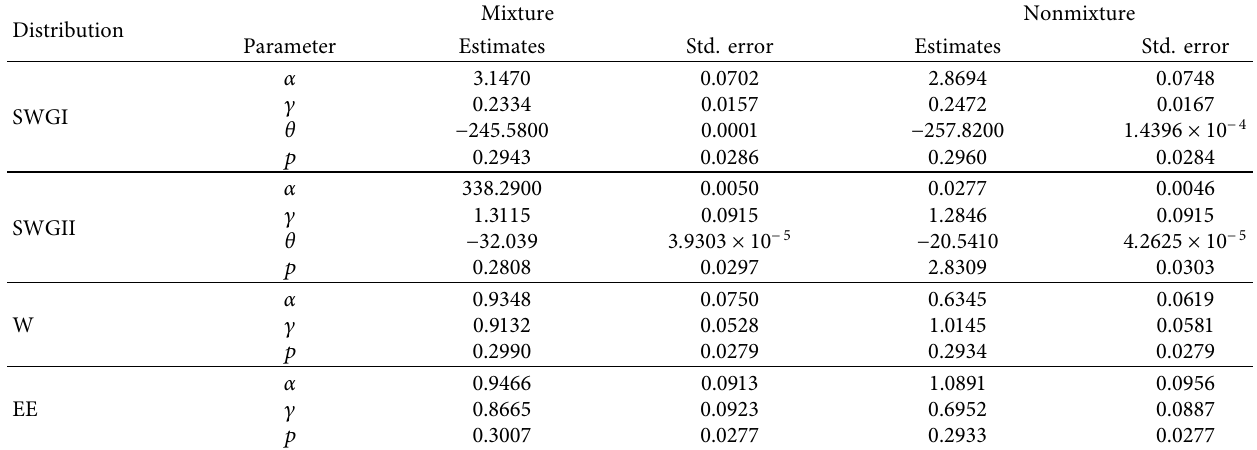
Table 7: Parameter estimates of mixture and nonmixture cure fraction models.